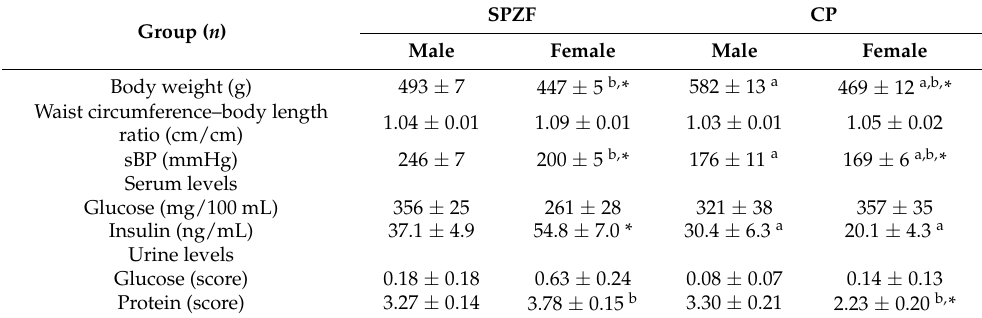
Table 1. Characteristics of SHRSP.Z- Lepr fa /IzmDmcr rats (SPZF) and SHR/NDmcr-cp rats (CP). Group ( n